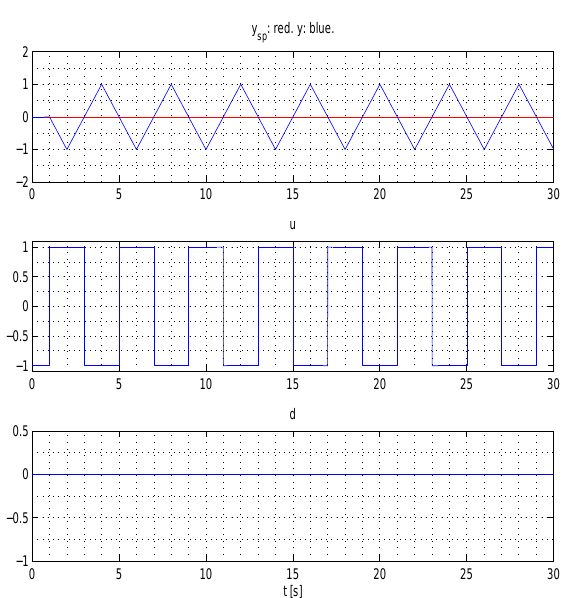
Figure 2: Responses during relay